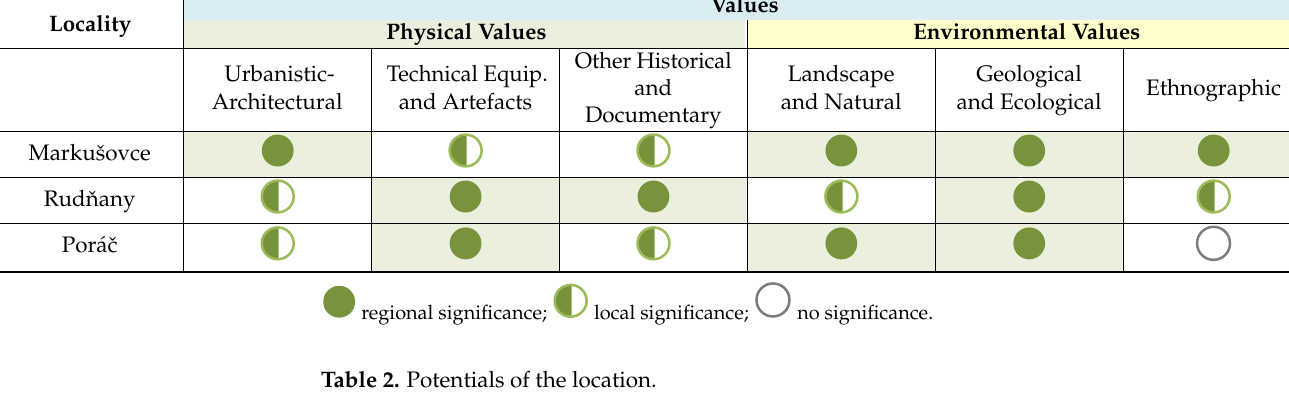
Table 1. Values of the location.